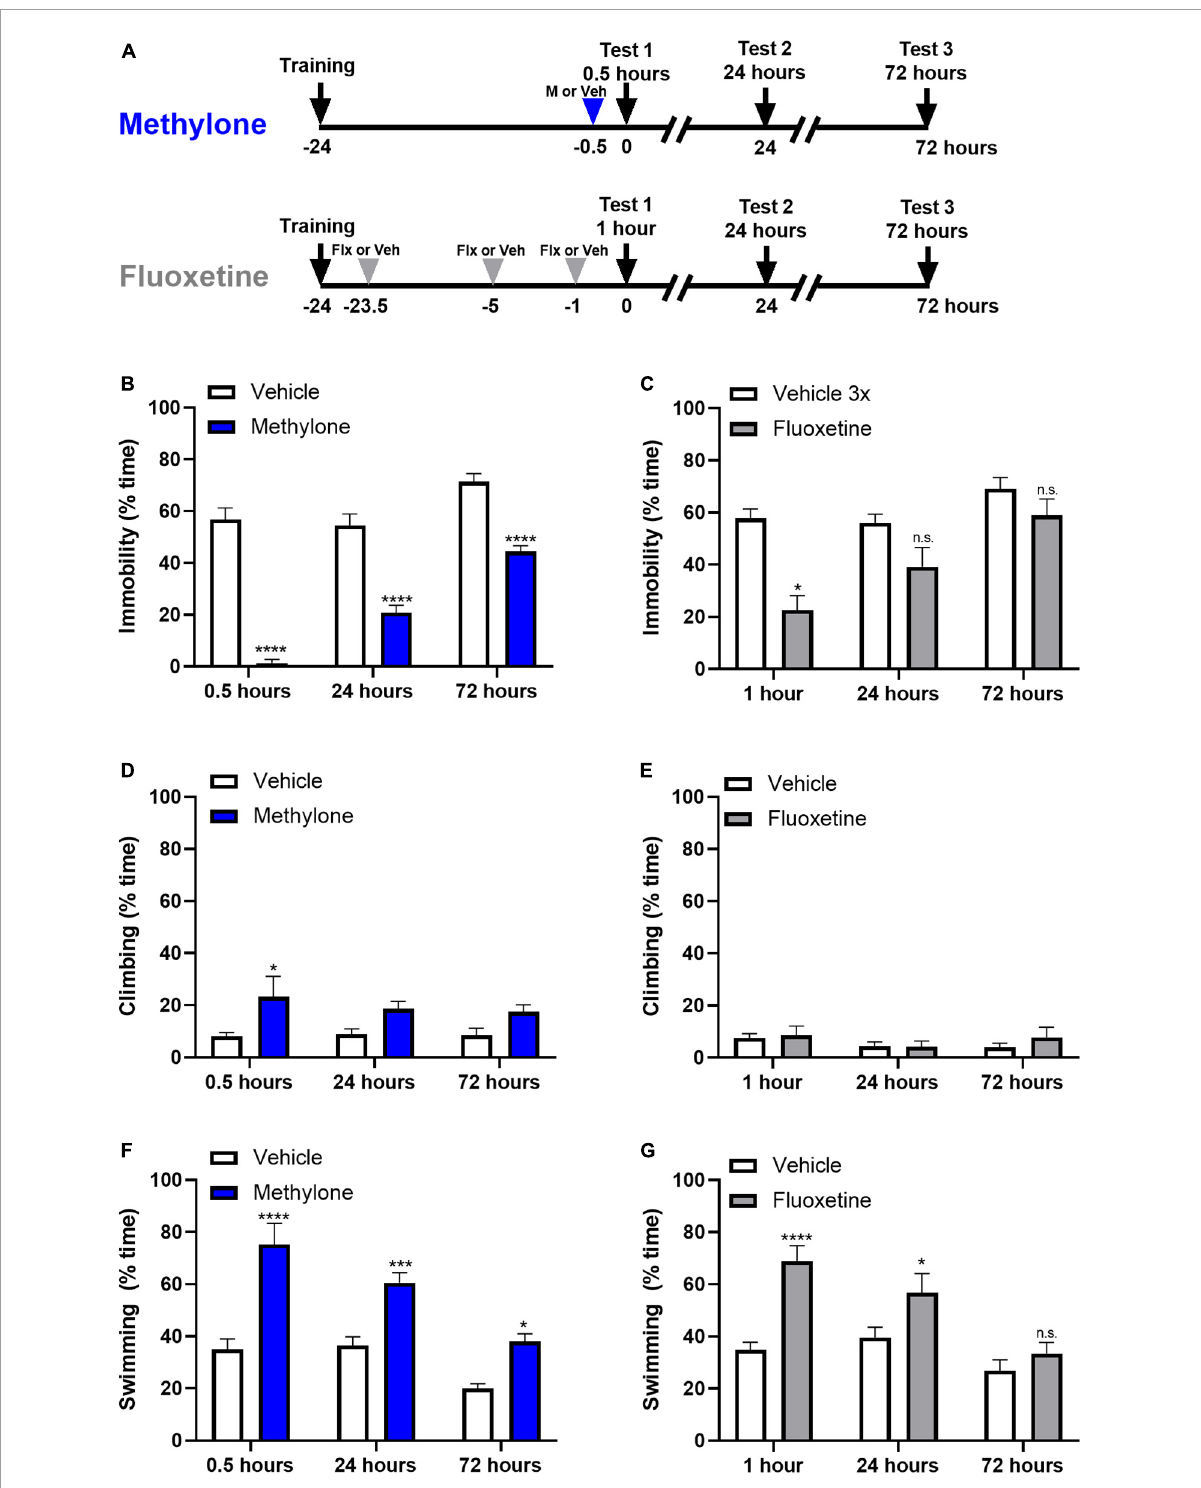
FIGURE3 The effect of a single dose of methylone is long-lasting. (A) Schematic shows experimental design. Methylone (15 mg/kg, IP) or saline (Vehicle) was administered 30 min prior to forced swim testing. Fluoxetine (10 mg/kg, IP) or saline (Vehicle) were administered 23.5, 5, and 1 h prior to testing. Animals were retested 24 or 72 h later. Quantification of the percent time spent (B,C) immobile, (D,E) climbing, or (F,G) swimming during each 5-test session is shown. Data are presented as means ± SEM. * p < 0.05, *** p < 0.001, **** p < 0.0001 vs. Vehicle control group; n.s., not significant, Bonferroni’s post-hoc test; N = 6–8 per